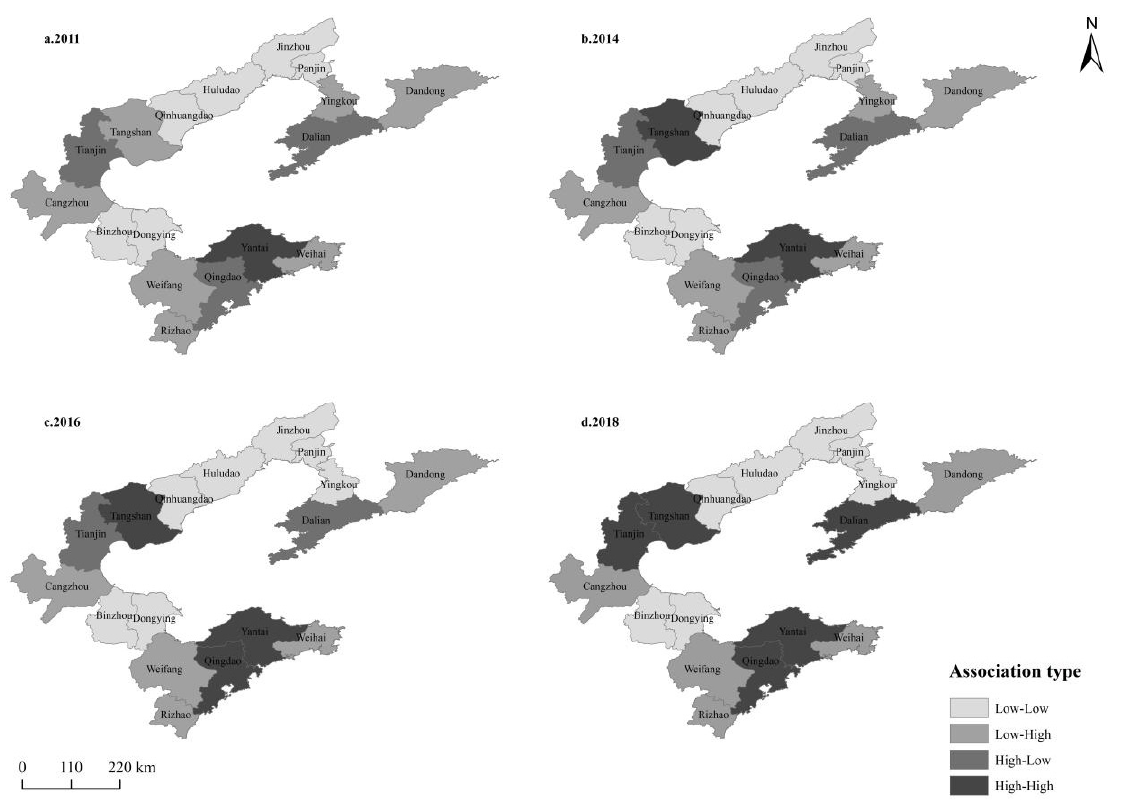
Figure 4. Local spatio-temporal Moran’s I of the sea–land integration ecological economic develop- ment level of cities around the Bohai Sea. Source: own study.